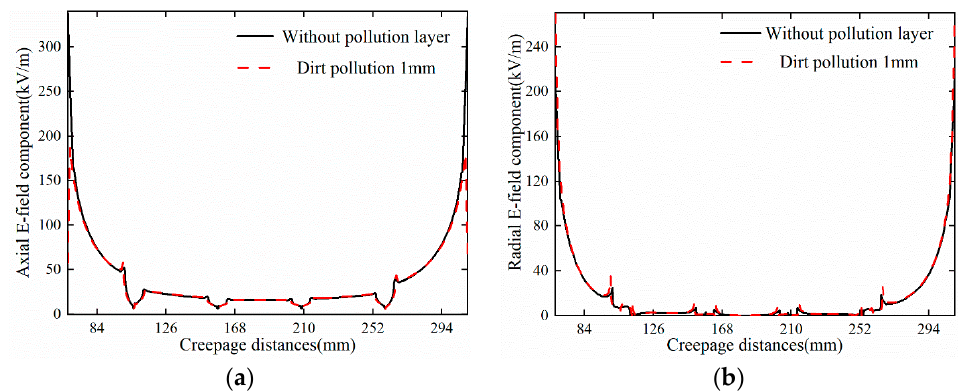
Figure 9. Distribution curves on the surface of the fouled composite insulator: ( a ) axial electric field; ( b ) radial electric field.